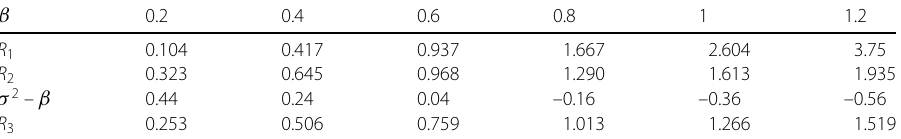
Table 3 The values with β = 0.2,0.4,0.6,0.8,1,1.2 β